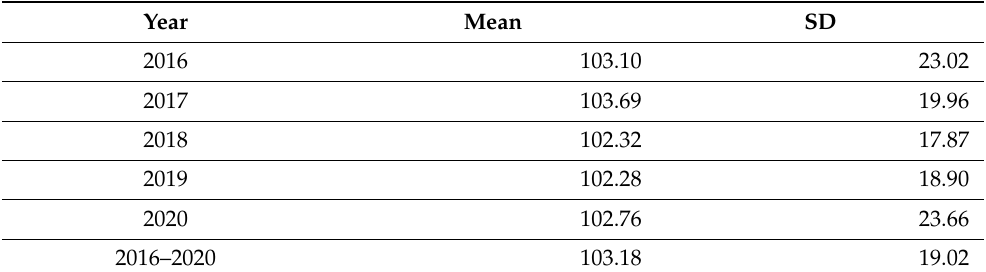
Table 5. Mean and SD of HSHRs.